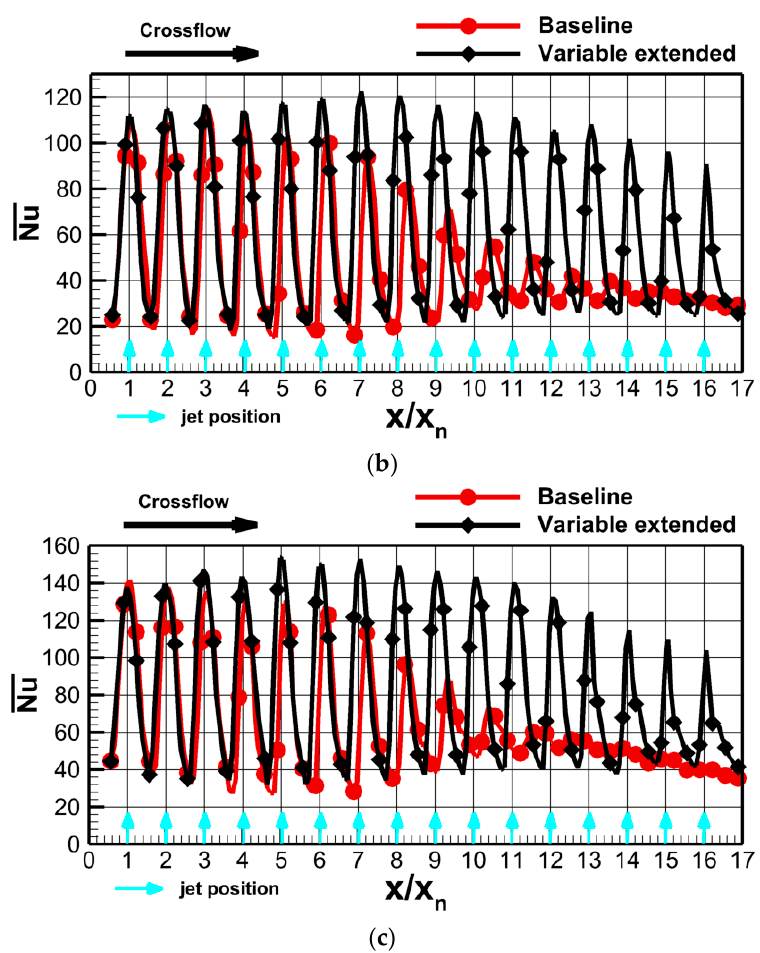
Figure 16. Comparisons of spanwise-averaged Nu between the baseline and variable extended cases: ( a ) Re j = 1.0 × 10 4 ; ( b ) Re j = 2.0 × 10 4 ; ( c ) Re j = 3.0 × 10 4 .